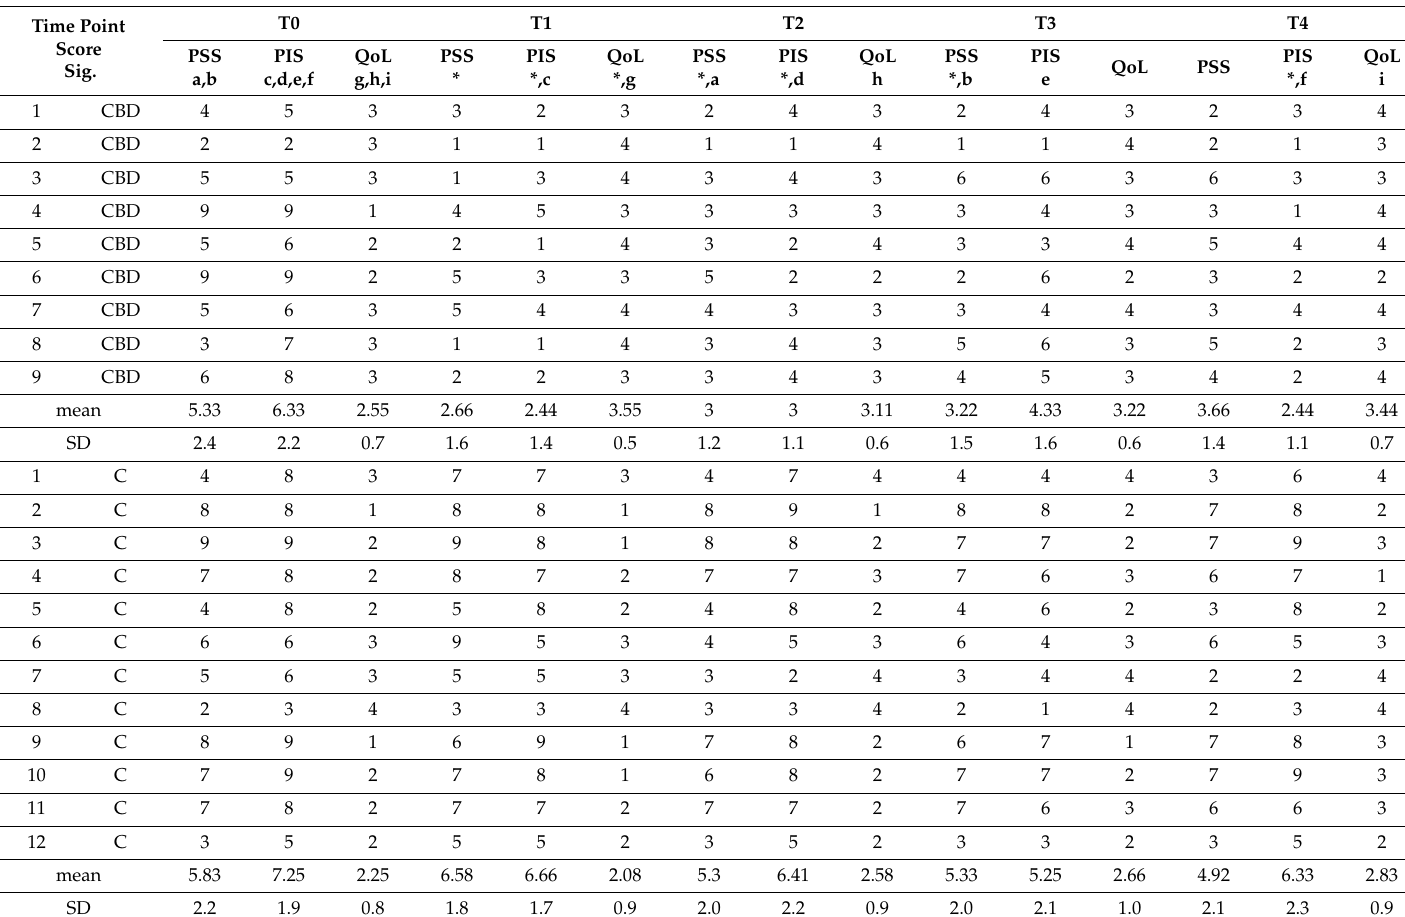
Table 3. Pain Severity Score (PSS), Pain Interference Score (PIS) and Quality of Life Index (QoL) (adopted by Brown et al., 2008) of the dogs enrolled in CBD ( n = 9) and C ( n = 12)